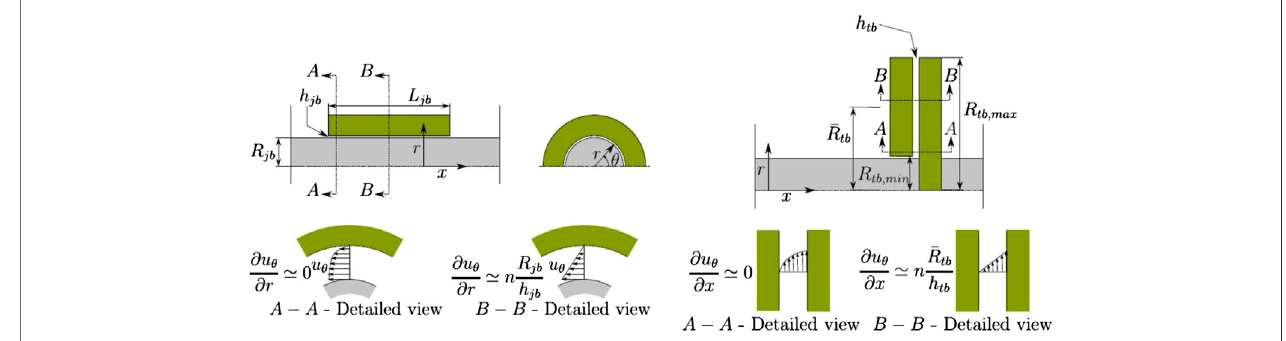
FIGURE 23 | Simpli fi ed schemes of a journal bearings (left) and a thrust bearing (right) , Serrano et al. (2013).